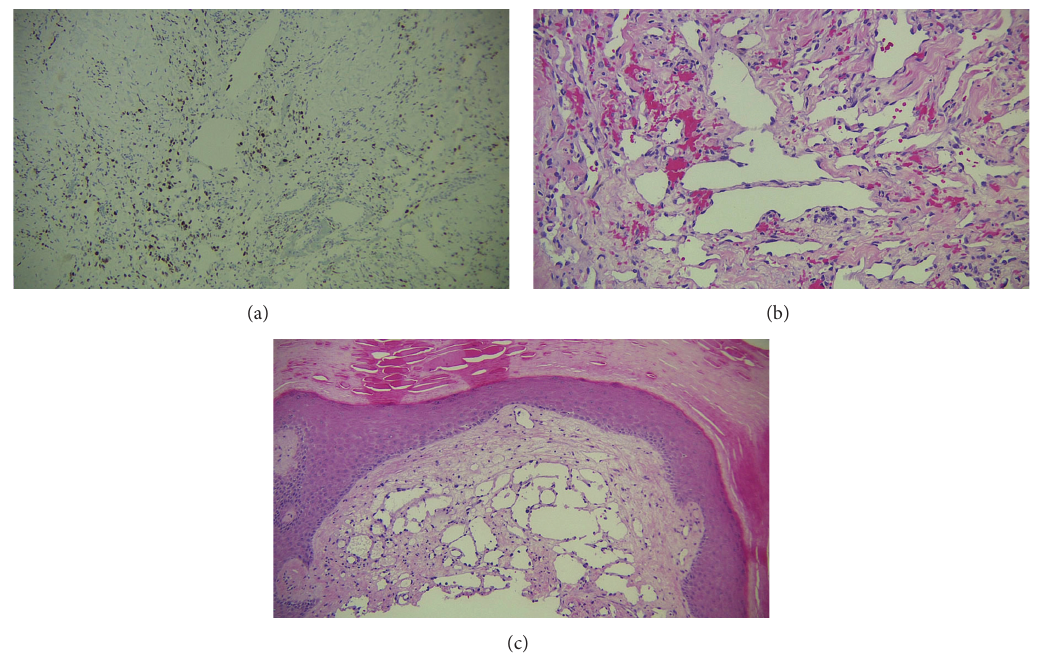
Figure 2: (a) Patient’s skin biopsy showing immunohistochemical stain for HHV8. There is a strong nuclear reactivity in the endothelial cells as well as some of the stromal spindle cell component. (b) and (c) H and E staining of skin biopsy from the patient. Within the dermis are markedly dilated vascular spaces lined by prominent endothelial cells. Within the stroma are few spindle cells without apparent atypia. This represents the lymphangioma-like variant of Kaposi